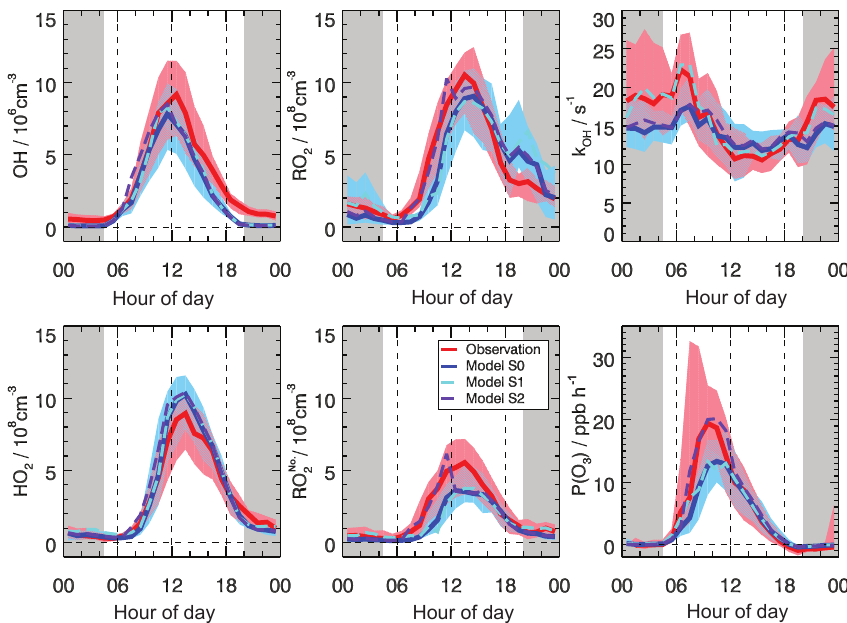
Figure 5. Comparison of hourly median diurnal profiles of OH, HO 2 , RO 2 , RO # concentrations and k OH and the ozone production rate 2 P ( O 3 ) (thick lines give median values, colored areas give the 25 and 75% percentiles). S0 denotes results from the base model run. S1 shows results when the VOC concentrations in the model are increased to match the observed OH reactivity. S2 shows results when an additional primary RO 2 source (2ppbvh − 1 ) is added in the model for the time between 06:00 and 12:00CST. Grey areas indicate